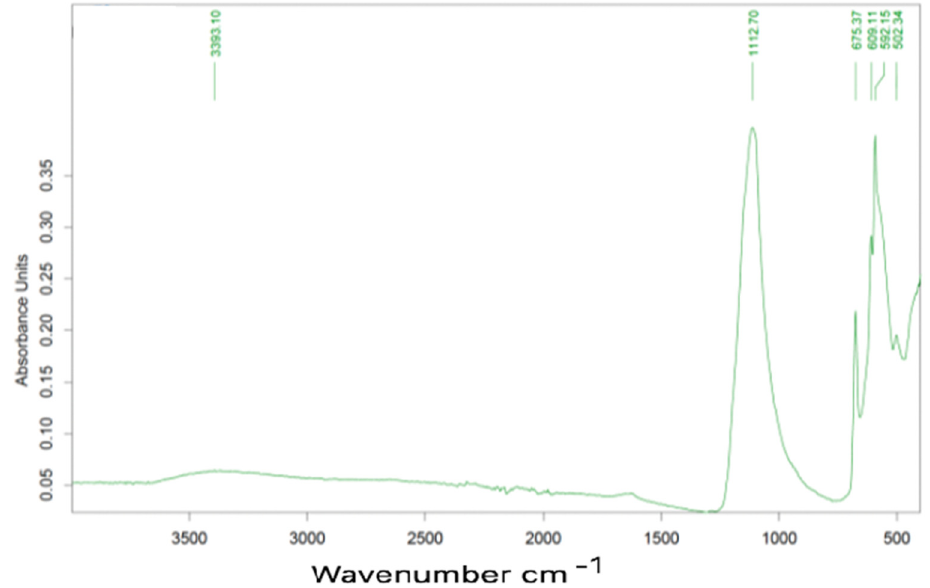
Figure 11. FTIR Spectrum of calcined sample.